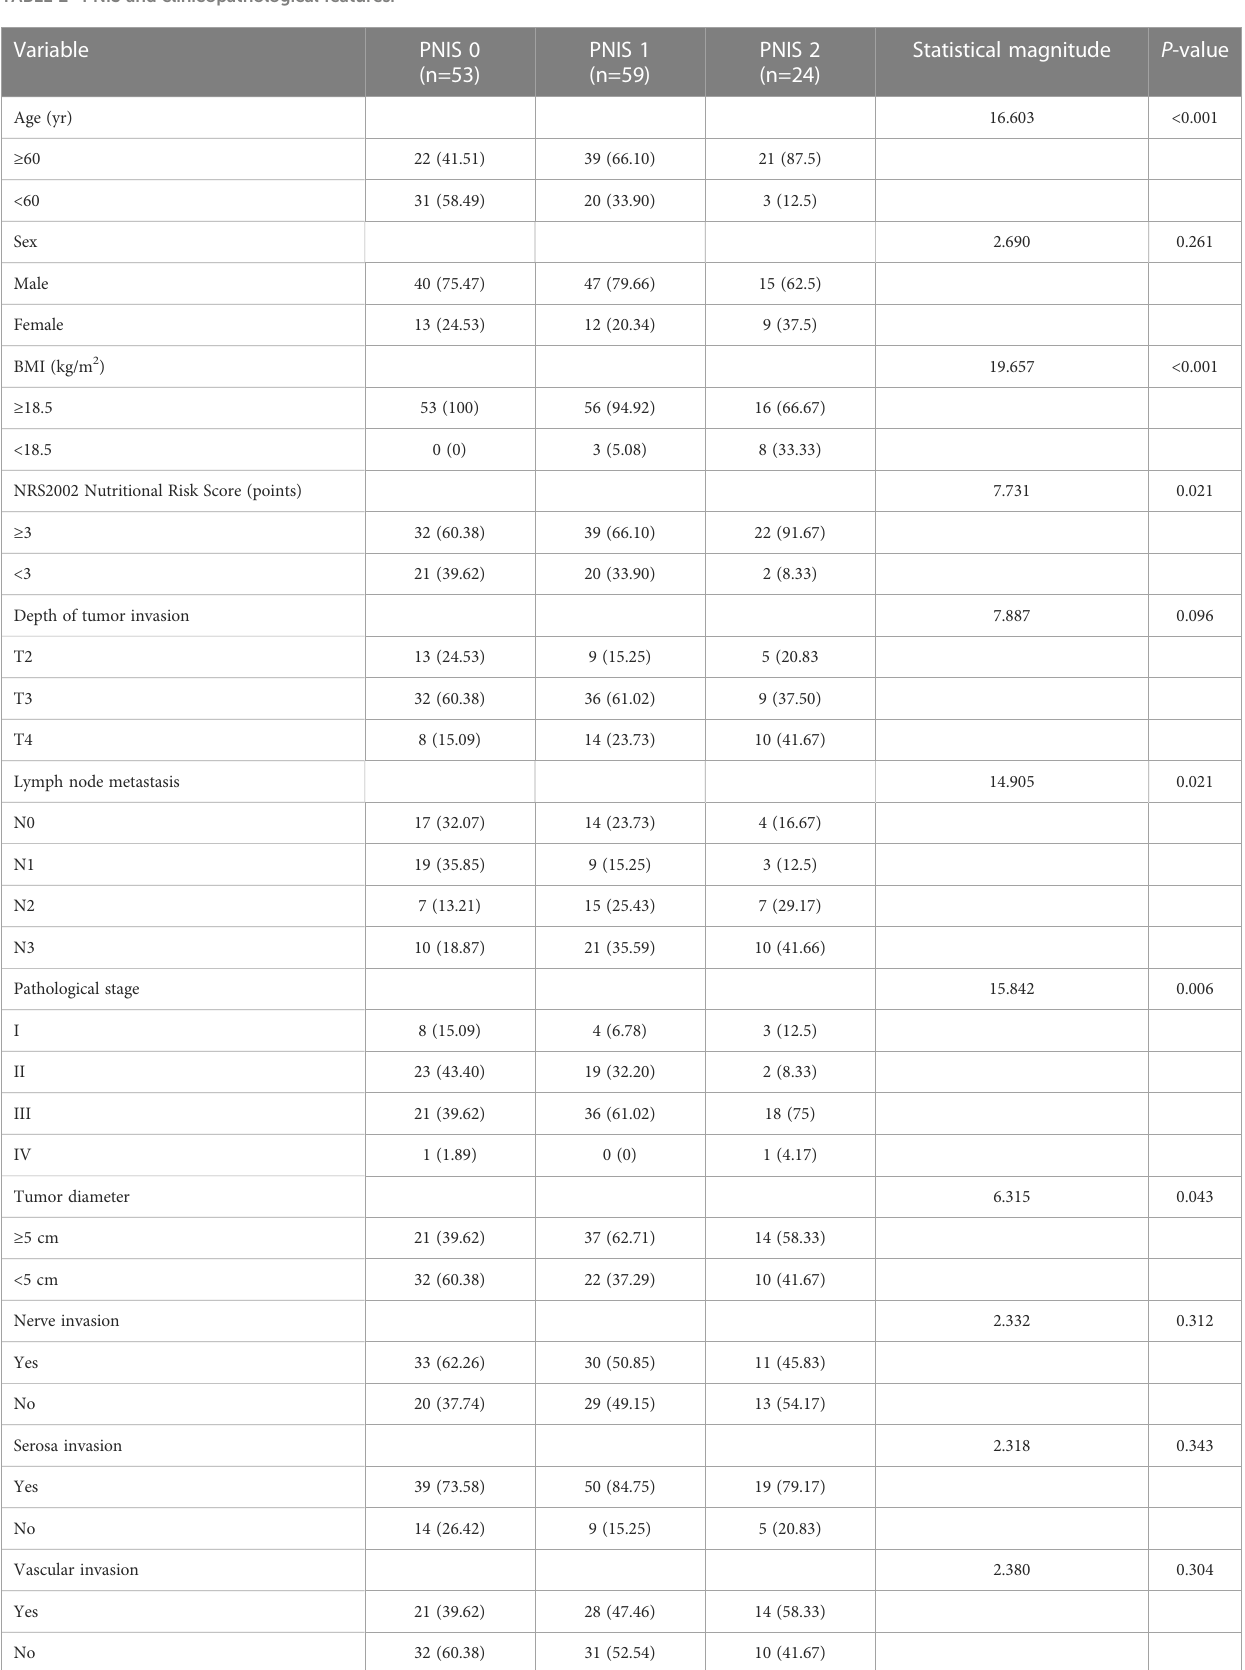
TABLE 2 PNIS and clinicopathological